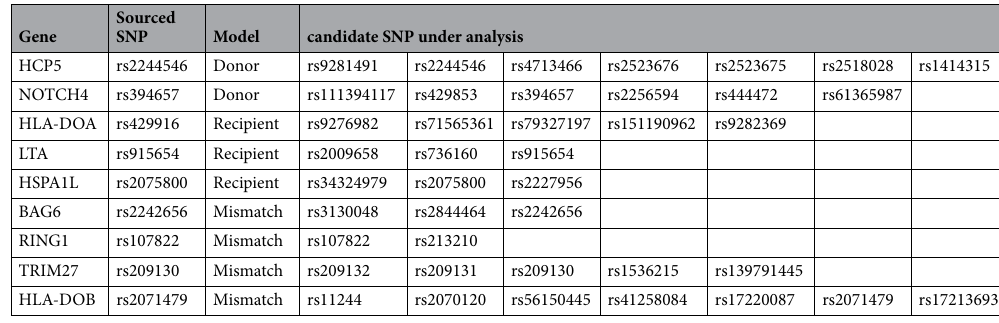
Table 4. The candidate SNPs that are within 500 bps upstream or downstream of the sourced